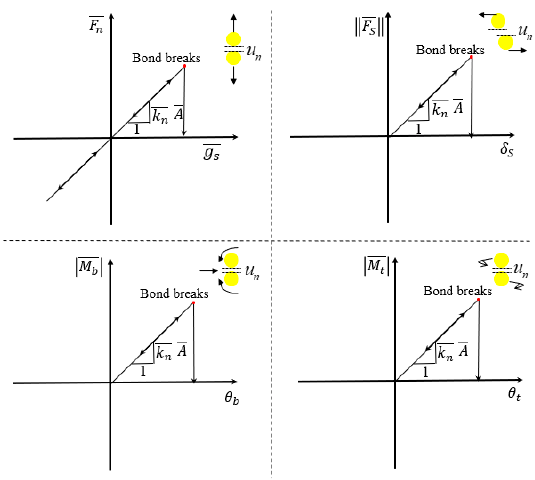
Figure 5. Schematic diagram of contact force displacement of parallel bonding model.